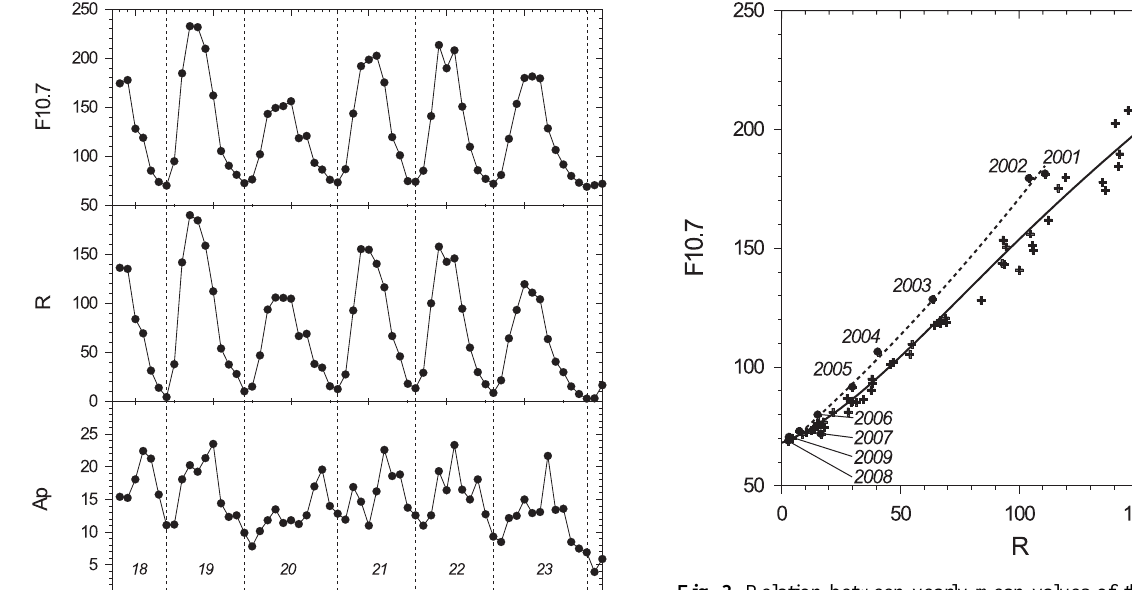
Fig. 3. Relation between yearly mean values of the solar 10.7cm radio flux F10.7 and the solar sunspot number R . The values from 1948 until 2000 are marked by crosses and are adapted by a poly- nomial fit of fourth order (continuous curve); the values from 2001 until 2009 are marked by full dots and are adapted by a polynomial fit of second order (dashed